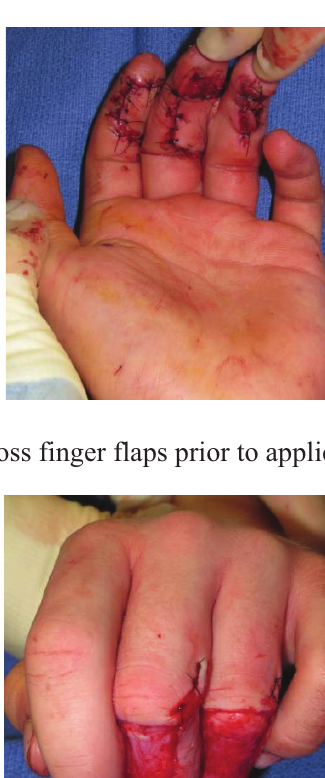
Figure 4. Cross finger flaps used for closure of traumatic defects of the index and long fingers.